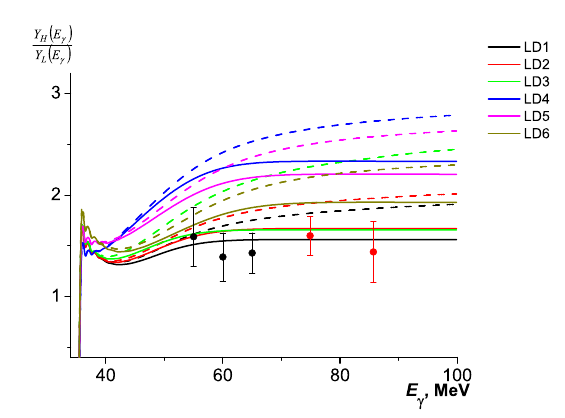
Figure 3. Solid line – calculation with using of code TALYS, red filled circles – experimental data obtained in this work, black circles – experimental values from